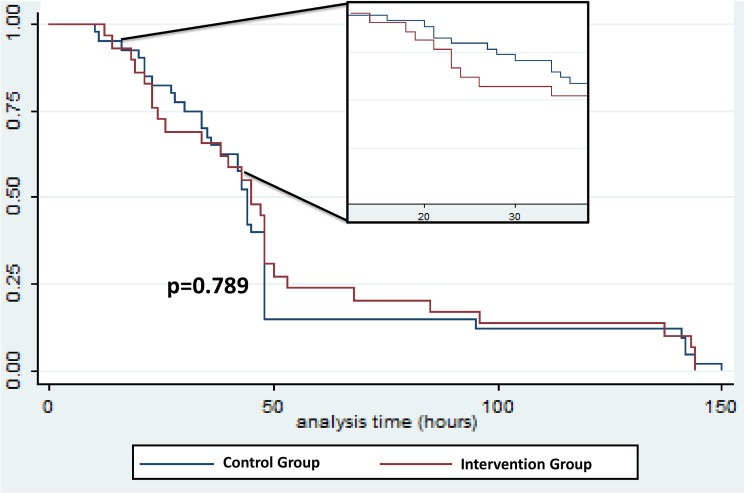
Time free of secondary infection at snakebite site, until 7 days after hospital admission, for both groups.Survival analysis demonstrating that the time from patient admission to the onset of secondary infection was not different between amoxicillin clavulanate treated and control group (Log-rank = 2.23; p = 0.789).